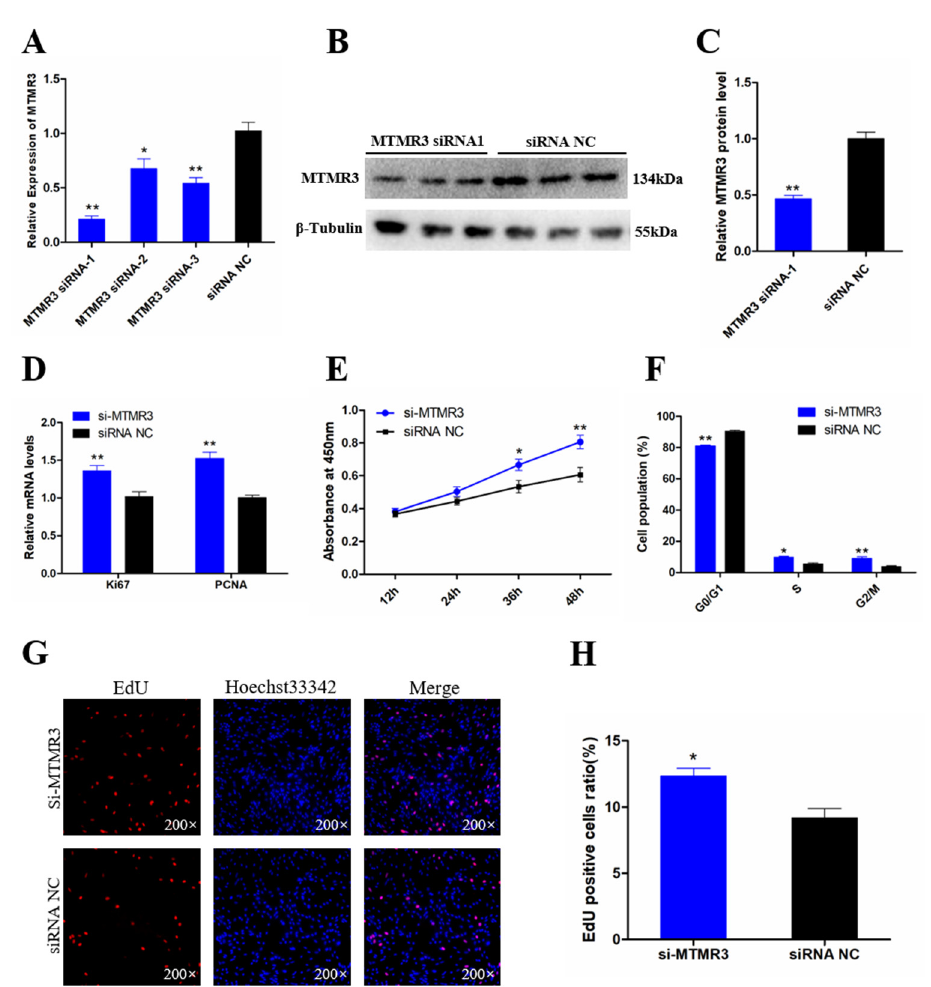
Figure 5. Knockdown MTMR3 facilitates chicken SMSCs proliferation. ( A ) The knockdown e ffi ciency of MTMR3 gene in SMSCs by three small interfering RNAs (siRNAs) were detected by qRT-PCR. ( B , C ) The protein expression level of MTMR3 after interference by MTMR3-siRNA1 was detected by Western blotting. ( D ) The mRNA levels of cell proliferation-related genes were detected by qRT-PCR in SMSCs after MTMR3 knockdown. ( E ) CCK-8 assays for SMSCs after MTMR3 knockdown. ( F ) The statistical results of cell cycle analysis for SMSCs after MTMR3 knockdown. ( G ) EdU staining after the transfection of MTMR3-siRNA1 in SMSCs. ( H ) Proliferation rates of chicken SMSCs following MTMR3 knockdown. Results are shown as mean ± SEM and the data are representative of at least three independent assays. Student’s t -test were used to compare expression levels among di ff erent groups. * p < 0.05; ** p <